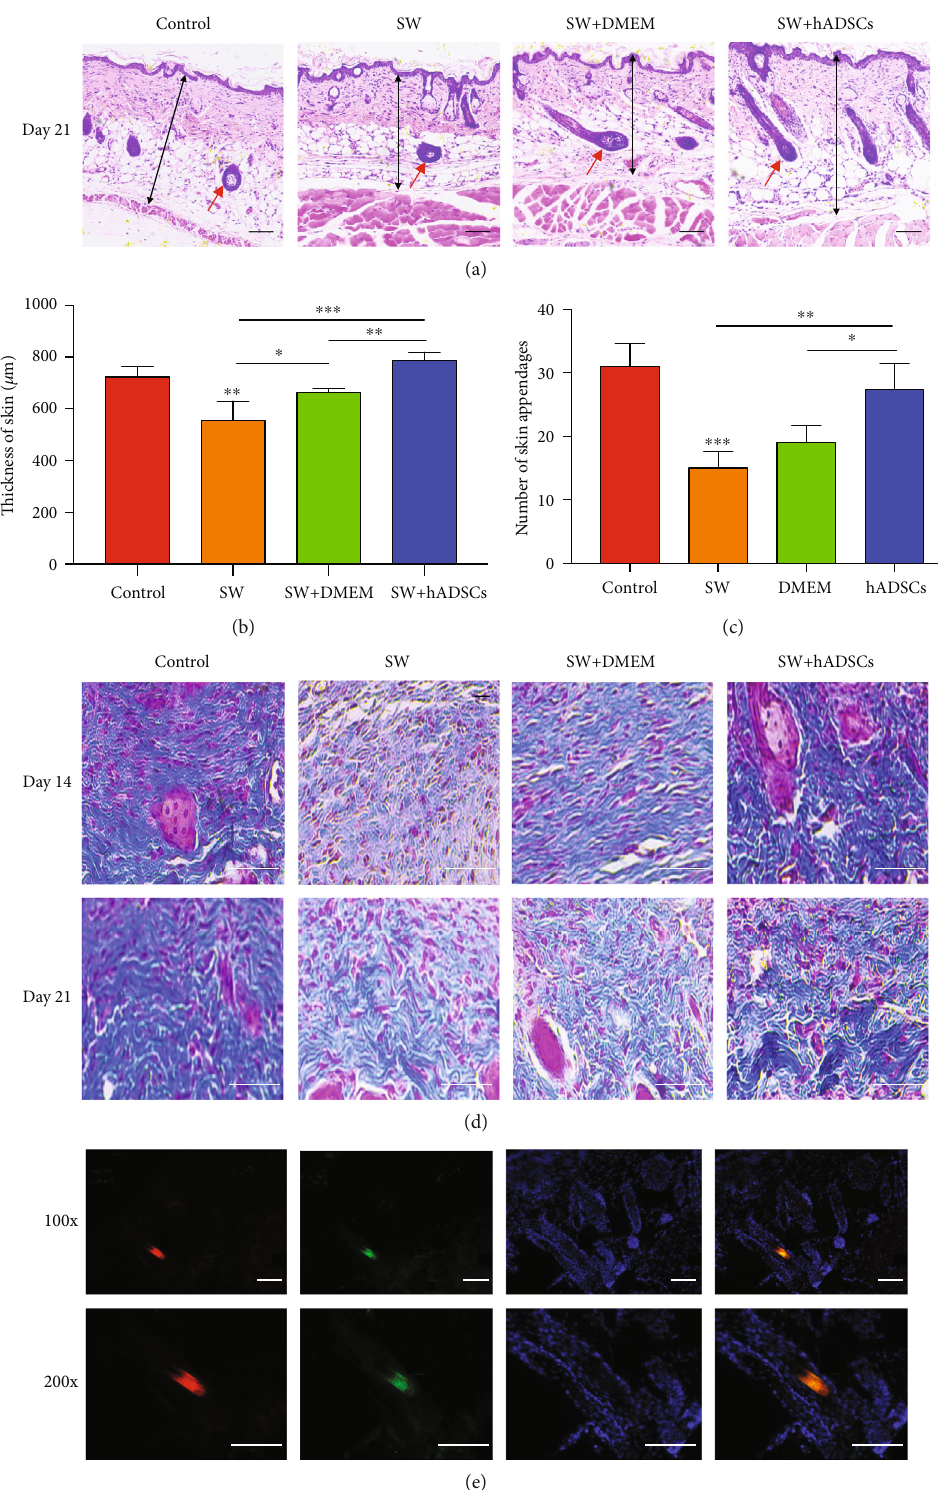
Figure 4: Microscopic evaluation of wound repair after SW and hADSC treatments. HE staining for wound repair, skin thickness, and number of subcutaneous appendages (a). The regeneration of skin thickness (b) and appendages (c) in the SW group and the SW+DMEM group was signi fi cantly decreased compared to that in the control group and the SW+hADSC group. Masson ’ s trichrome staining of wounds in each group (d). Scale bars indicate 100 μ m. ∗ P < 0 : 05 , ∗∗ P < 0 : 01 , and ∗∗∗ P < 0 : 001 . The red arrow refers to a hair follicle. The frozen section immuno fl uorescence showed that hADSCs (CM-DIL, red) di ff erentiated into skin stem cells (cytokeratin 19, CK19, green) to promote wound healing